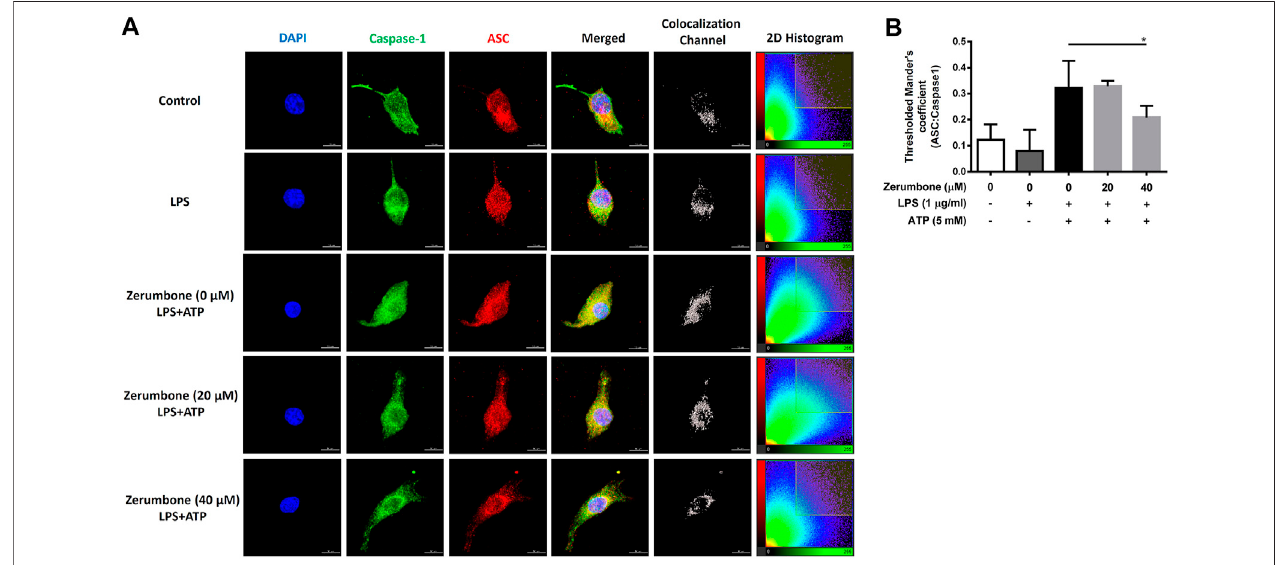
FIGURE5| TheeffectsofzerumboneonthecolocalizationofNLRP3in fl ammasomecomponents(ASCandcaspase-1)inLPS/ATP-activatedJ774 A.1cells.Cells werepre-treatedwithvariousdosesofzerumbonefor1 handthentreatedwithLPS(1 μ g/ml)for5 hfollowingtreatmentofATP(5 mM)for30 min. (A) Cellswerestained with caspase-1 (green), ASC (red), and DAPI (blue) and then analyzed using confocal microscopy and Imaris software for confocal image 3D reconstruction (B) ASC speckformationwasanalyzedbythethresholdof2DhistograminpanelAtodeterminethecolocalizationofcaspase-1andASCsignalsusingMander ’ scoef fi cient. Data were represented as means ± SD. Statistical signi fi cance between the zerumbone-treated groups vs. the LPS/ATP group is represented as follows: * p < 0.05.